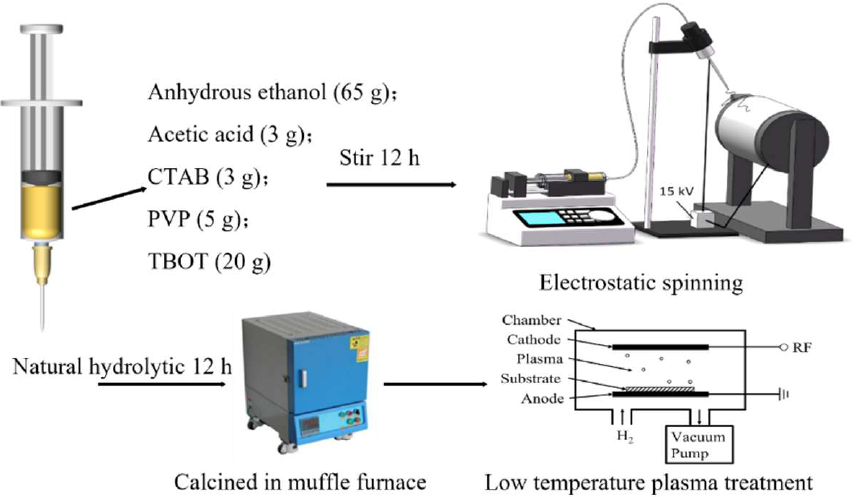
Figure 13. Process flow chart of electrospinning TiO 2 fiber preparation; heat treatment and plasma modification.